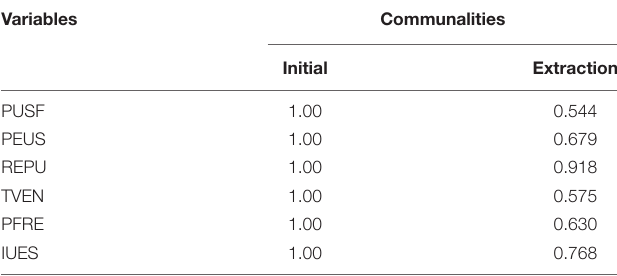
TABLE 7 | Communality findings.